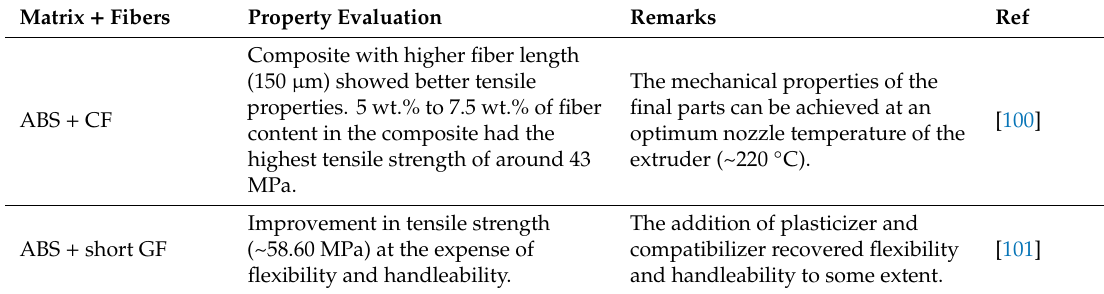
Table 1. A summary of different fiber reinforcements into polymer matrices using FDM.